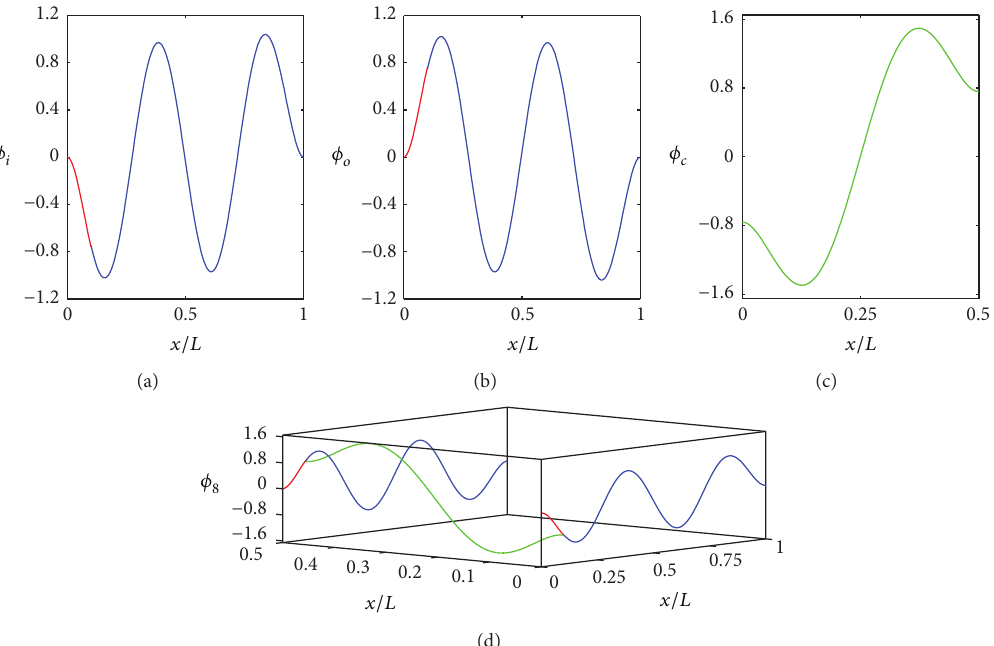
Figure 9: Eighth mode shape of the filter: (a) input, (b) output, (c) coupling beams, and (d) combination of (a), (b), and (c).